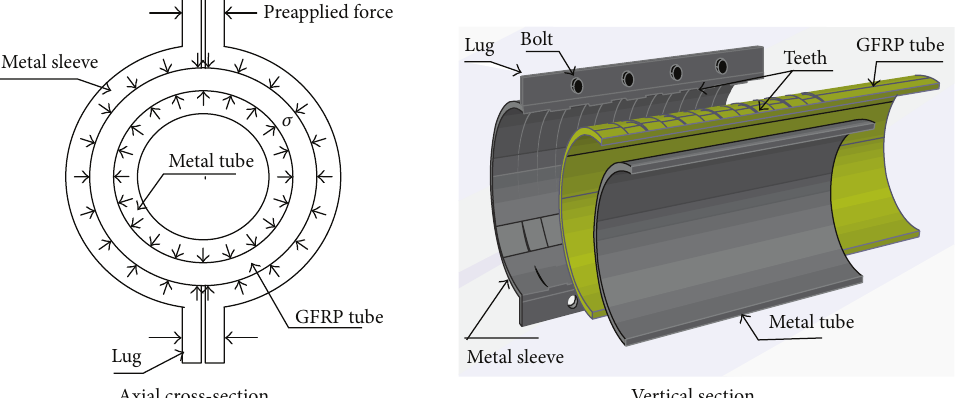
Figure 5: Schematic diagram of the joint.